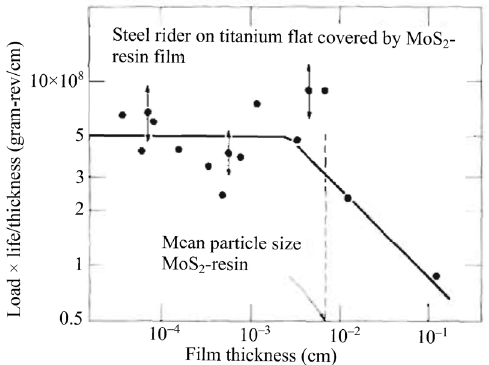
Fig. 3 The function load × life time/thickness plotted as a function of thickness for titanium flat surfaces lubricated by MoS 2 -resin (reproduced from Ref.